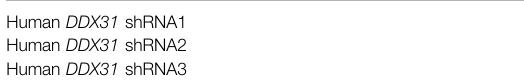
TABLE 3 | shRNA sequences of DDX31 . shRNA sequences for stable knockdown cell lines Human DDX31